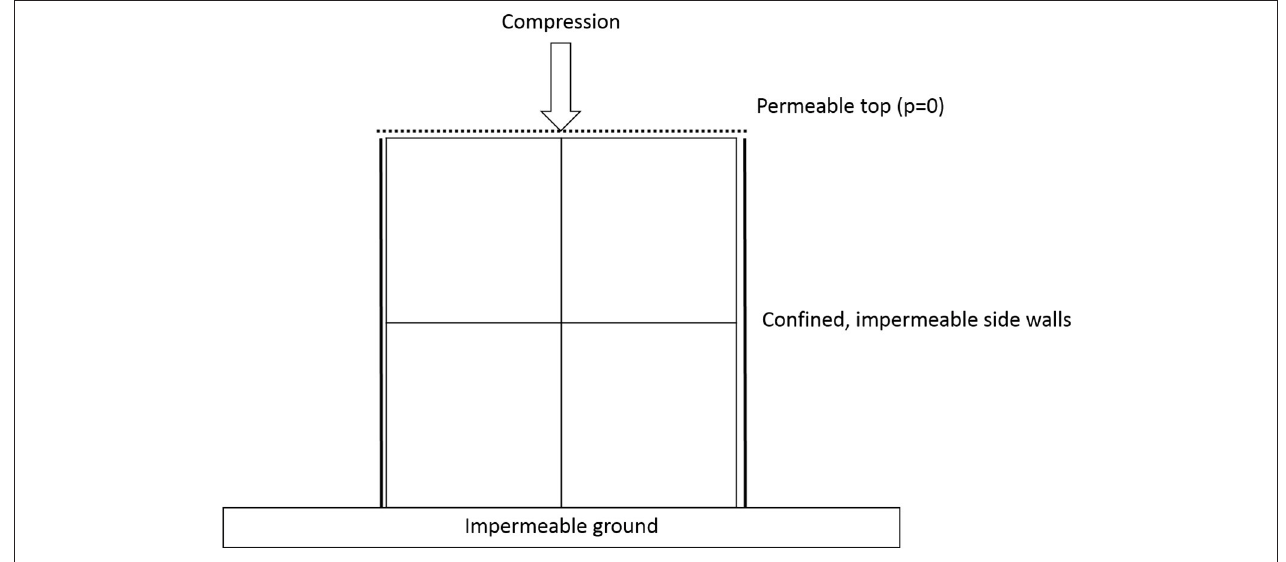
FIGURE 2 | Schematic representation of the boundary conditions applied in this study. TABLE 1 | Constitutive properties of the different collagen hydrogels (Busby et al., 2013; Castro et al., 2016). Collagen